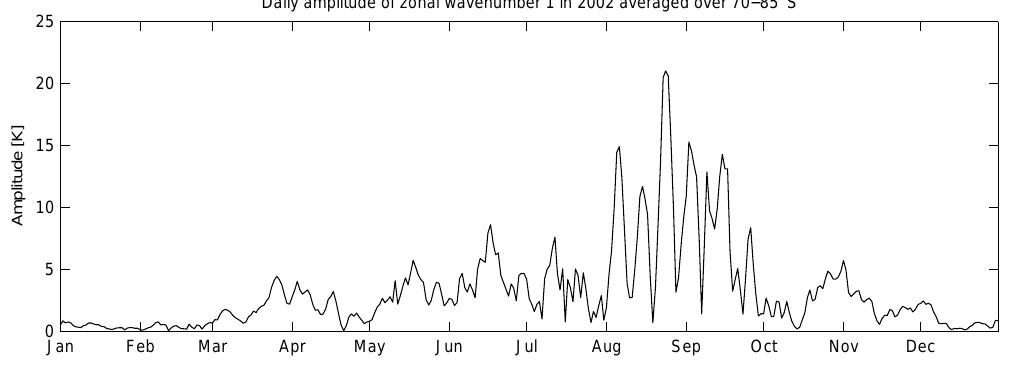
Fig. 7. Top: Longitude-time map of NCEP temperatures at 10hPa and at 85 ◦ S latitude. Bottom: Power spectrum of the NCEP temperatures shown in the top panel showing the presence of a strong zonal waveumber 1 and 10-day fluctuation in the data.